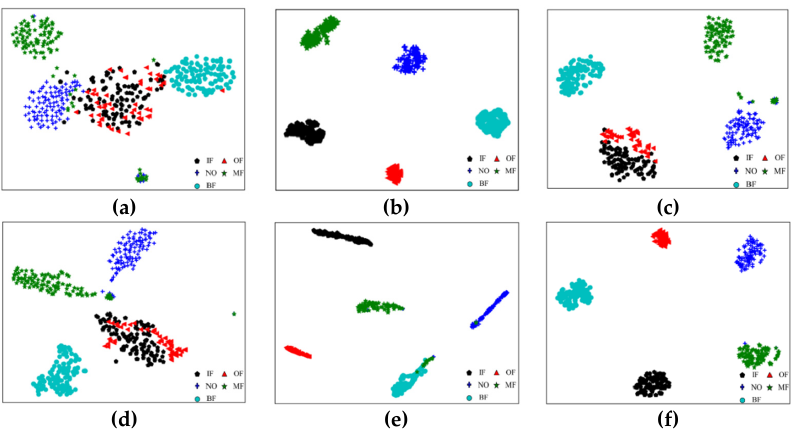
Figure 12. Visualization of bearing fault diagnosis results of all the models: ( a ) 2D-CNN ( b ) the proposed model MCDS-CNN; ( c ) AlexNet; ( d ) LeNet5; ( e ) MobileNet; ( f ) ResNet18.